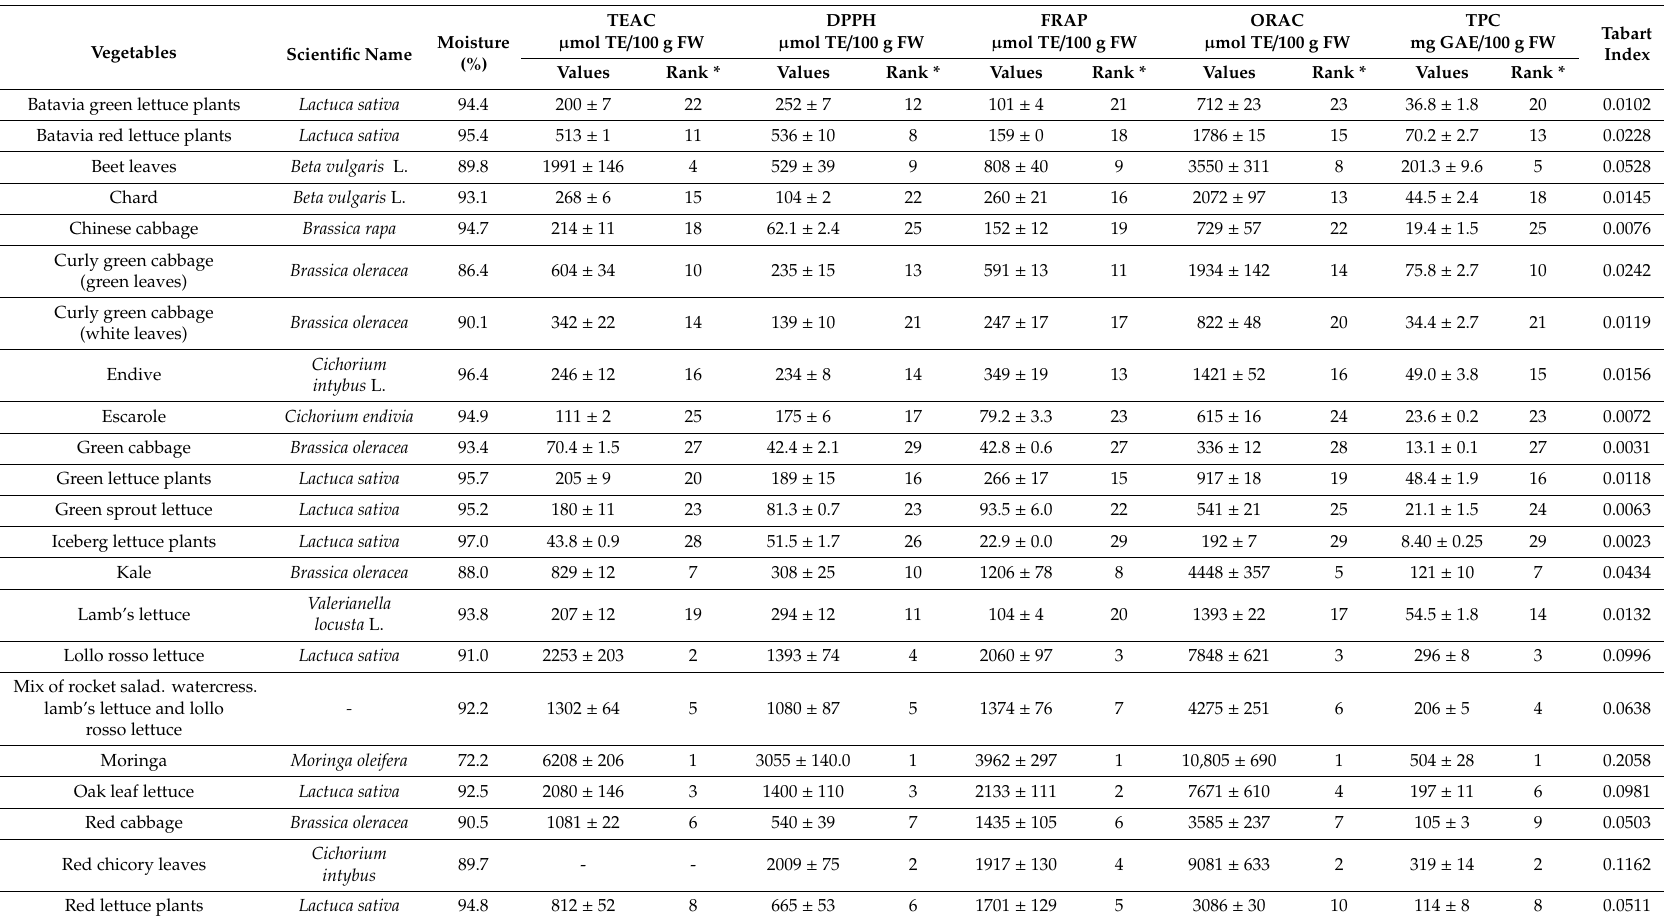
Table 1. Vegetables analyzed, moisture content, mean values of total antioxidant capacity, and total polyphenol content determined by the methanol–water extraction method